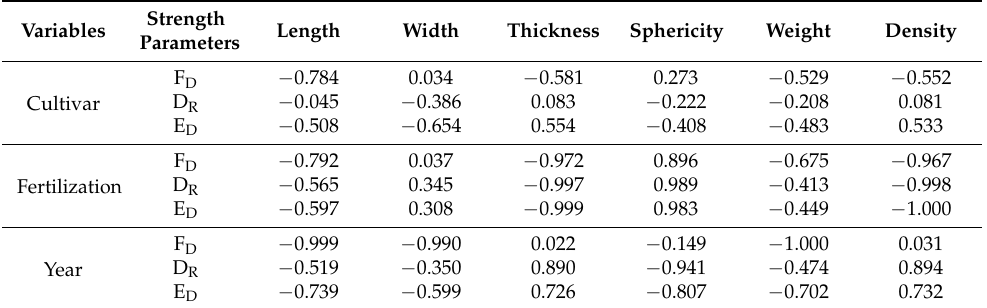
Table 4. Correlation coefficients (r) between the strength parameters of pea seeds and their morpho- logical features. Strength Variables Length Width Sphericity Parameters